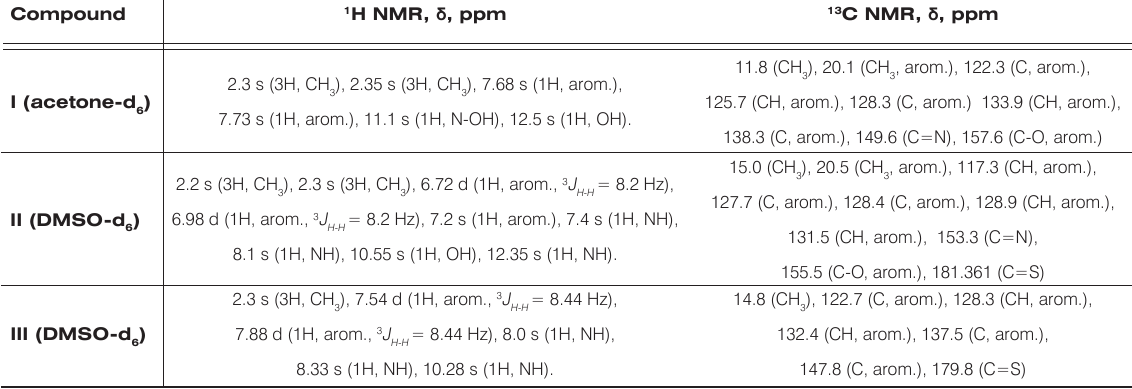
Table 1. 1 H, 13 C NMR data of compounds I-III . Compound